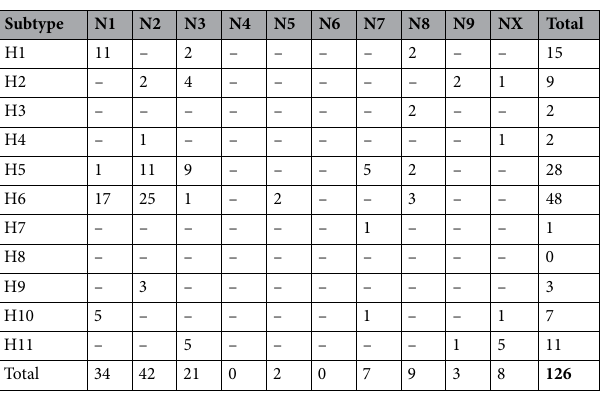
Table 2. Distribution of influenza A virus HA and NA subtypes among 126 avian influenza virus